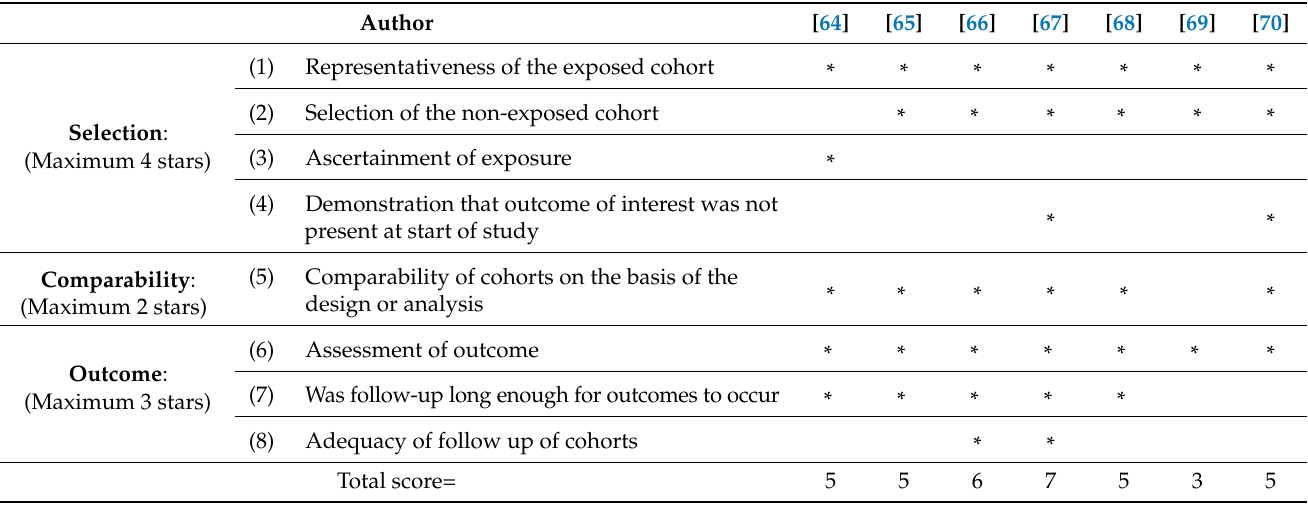
Table 3. Newcastle–Ottawa quality assessment scale: cohort